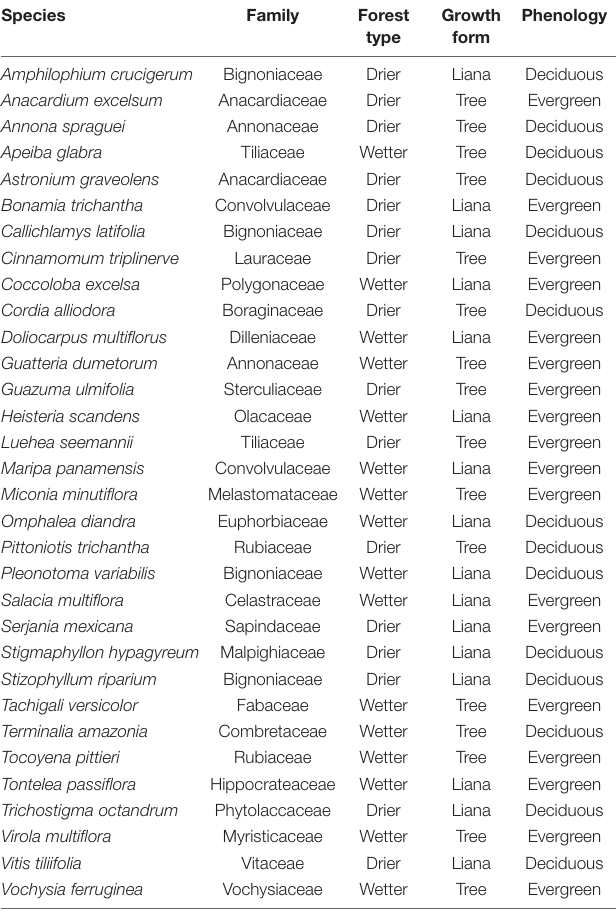
TABLE 1 | List of 32 species, their families, the type of forest they occur in (drier Parque Natural Metropolitano or wetter Parque Nacional San Lorenzo), their growth form (liana or tree), and their leaf phenology (deciduous or evergreen) at our study sites based on Medina-Vega et al.